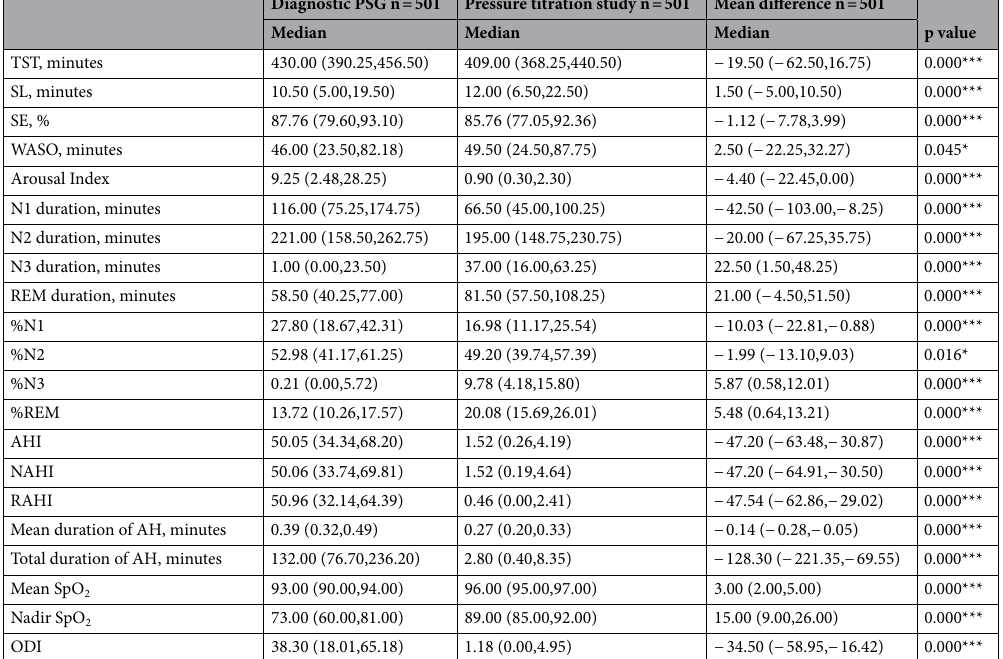
Table 1. Differences between diagnostic and pressure titration PSG. AH apnea and hypopnea, AHI apnea– hypopnea index, NREM non-rapid eye movement sleep, NAHI non-rapid eye movement sleep apnea– hypopnea index, ODI oxygen desaturation index, RAHI non-rapid eye movement sleep apnea–hypopnea index, REMs rapid eye movement sleep, SE Sleep efficiency, SL sleep latency, SpO 2 pulse oxygen saturation, TST Total sleep time, WASO wake after sleep onset.